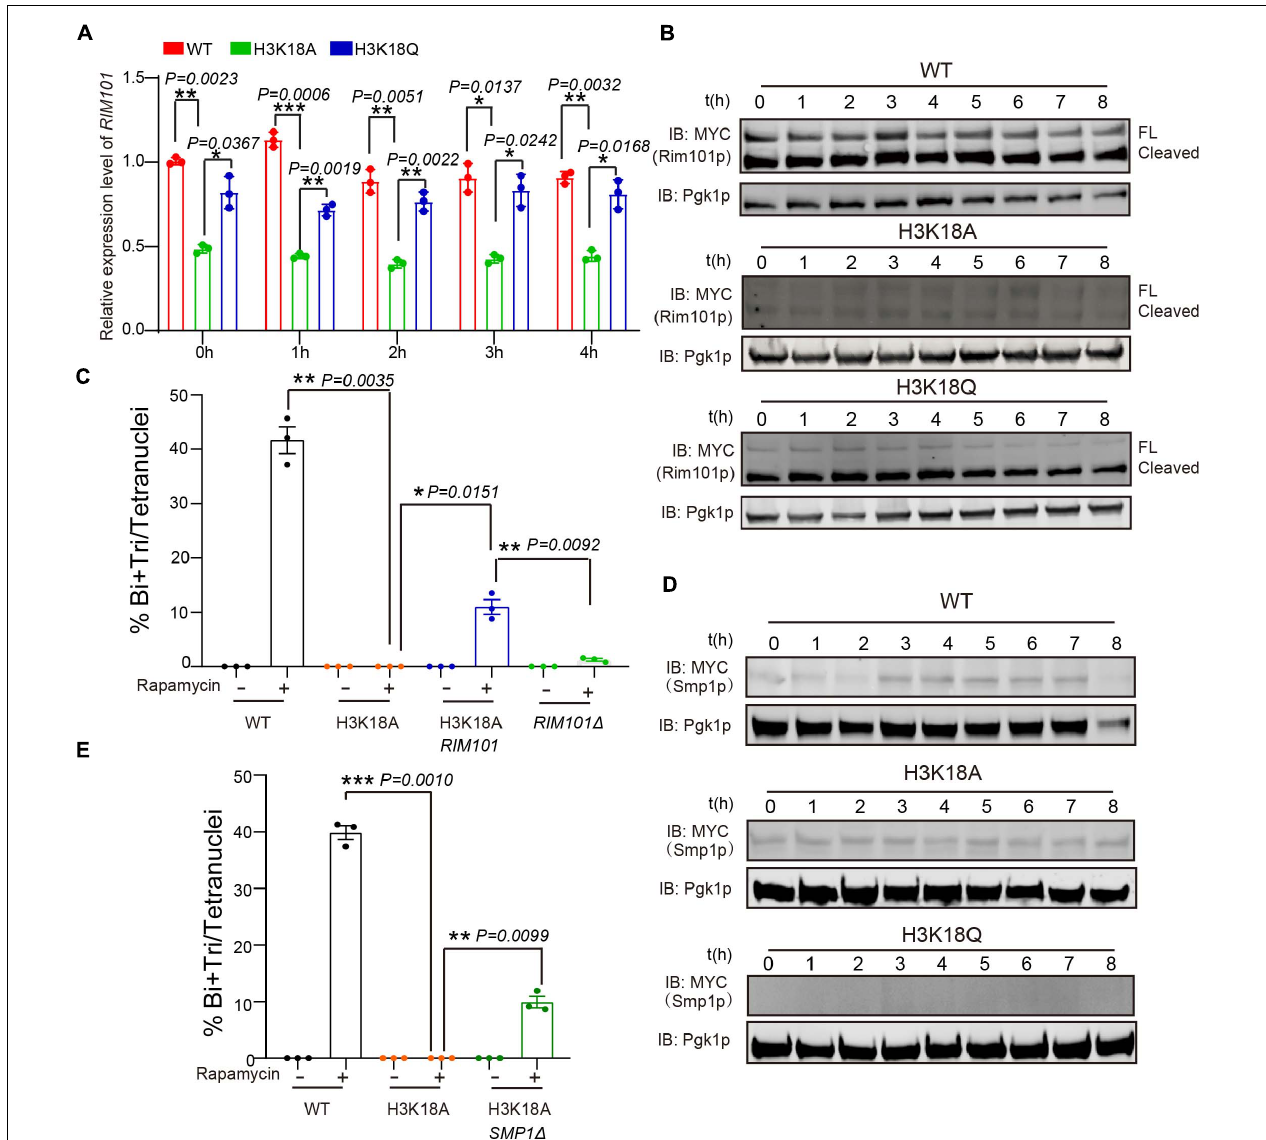
FIGURE 5 | H3K18ac influences meiosis initiation by regulating RIM101 and SMP1 expression. (A) Quantitative PCR analyzed RIM101 expression in WT, H3K18A and H3K18Q mutant strains. Cells were harvested at the indicated times and then total RNA was extracted and reverse transcribed. RIM101 mRNA levels in the three strains were measured by quantitative PCR and normalized to the levels of the house keeping gene TAF10 . The error bars indicate ± SD ( n = 3). * P < 0.05, ** P < 0.01, *** P < 0.001. (B) Western blot of Rim101p expression in WT, H3K18A, and H3K18Q mutant strains during sporulation. RIM101 in all three strains was tagged with 9 × Myc. Pgk1p was used as a loading control. WT-9MYC- RIM101 : LW1634; H3K18A-9MYC- RIM101 : LW1635; H3K18Q-9MYC- RIM101 : LW1636. (C) Overexpression of RIM101 in H3K18A mutant strain could partly rescue the sporulation induced by rapamycin in YPD medium. Indicated cells were cultured in YPD for 24 h at 30 ◦ C, then induced by rapamycin or methanol as control. Sporulation efficiency were analyzed at 36 h after treatment. Error bar indicate ± SD ( n = 3). * P < 0.05, ** P < 0.01. H3K18A Rim101p: LW1641; RIM101 (cid:49) : LW1560. (D) Western blot of Smp1p expression in WT, H3K18A and H3K18Q mutant strains during sporulation. SMP1 in all three strains was tagged with 9 × Myc. Pgk1p was used as a loading control. WT- SMP1 -9MYC: LW1637; H3K18A- SMP1 -9MYC: LW1638; H3K18Q- SMP1 -9MYC: LW1639. (E) Delete SMP1 in H3K18A mutant strain could partly rescue the sporulation induced by rapamycin in YPD medium. Indicated cells were cultured in YPD for 24 h at 30 ◦ C, then induced by rapamycin or methanol as control. Sporulation efficiency were analyzed at 36 h after treatment. Error bar indicate ± SD ( n = 3). ** P < 0.01, *** P < 0.001. H3K18A SMP1 (cid:49) :